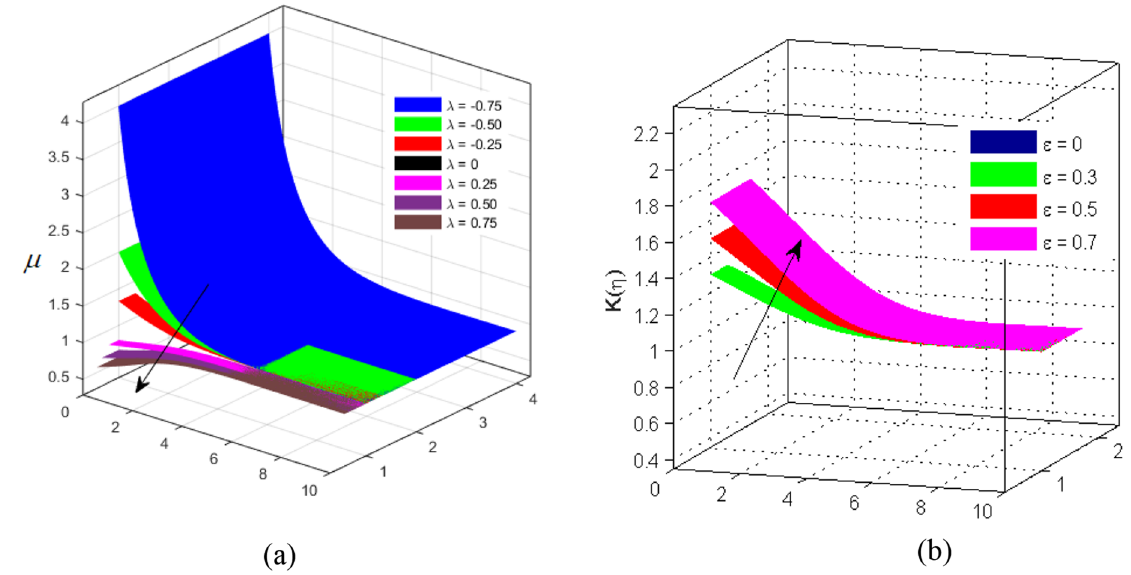
Figure 13. Variations of (cid:31) and ε to µ and K (η) respectively.